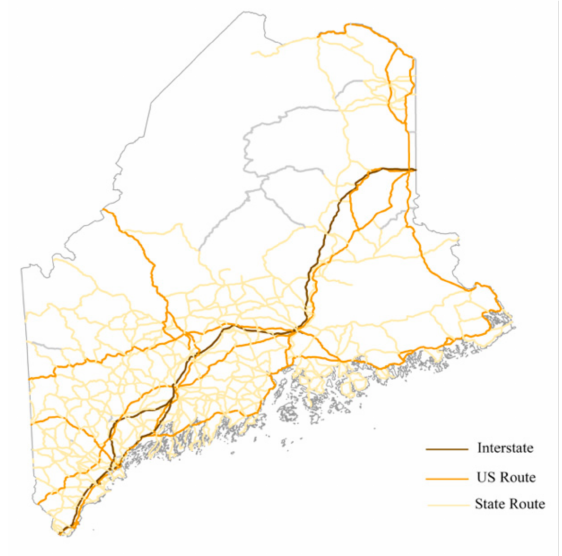
Figure 11. Distribution of road types in Maine.